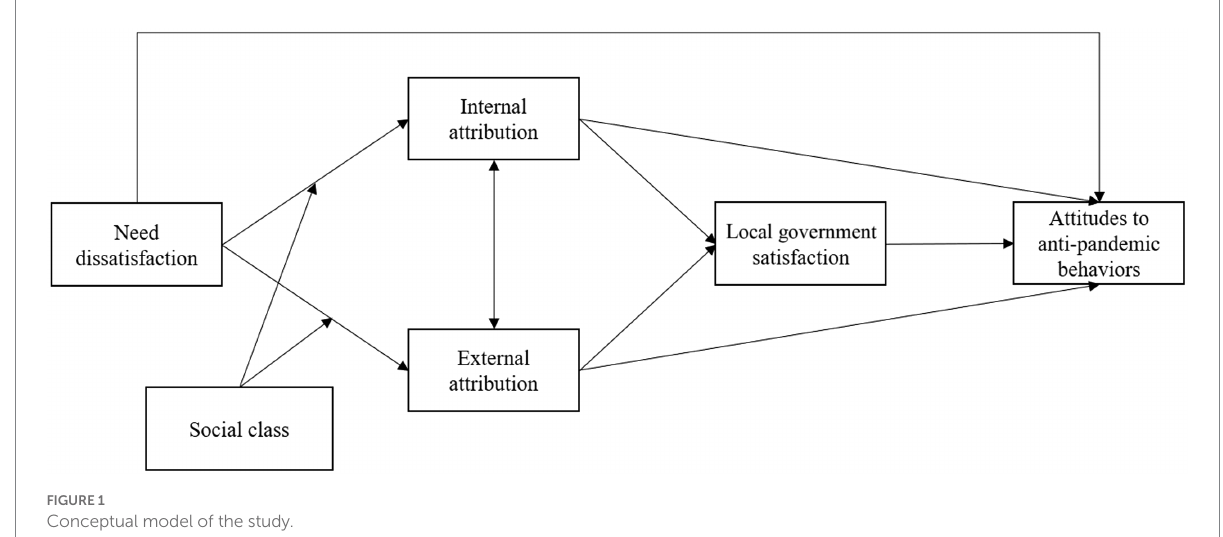
FIGURE 1 Conceptual model of the